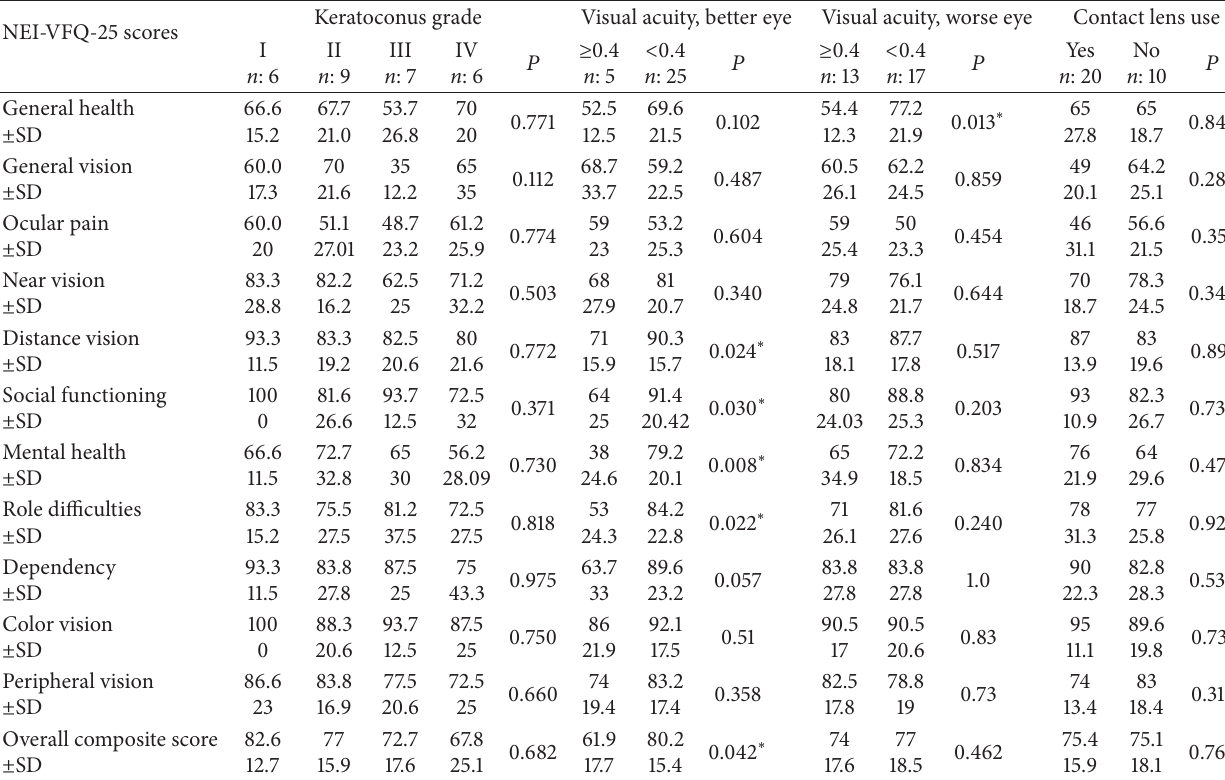
Table 3: Comparison of NEI-VFQ-25 subscale item scores in the keratoconus group according to the subgroups of the keratoconus grade; visual acuity in the better and worse eye and contact lens use are presented ( ∗ 𝑃 < 0.05 ; ∗∗ 𝑃 < 0.001